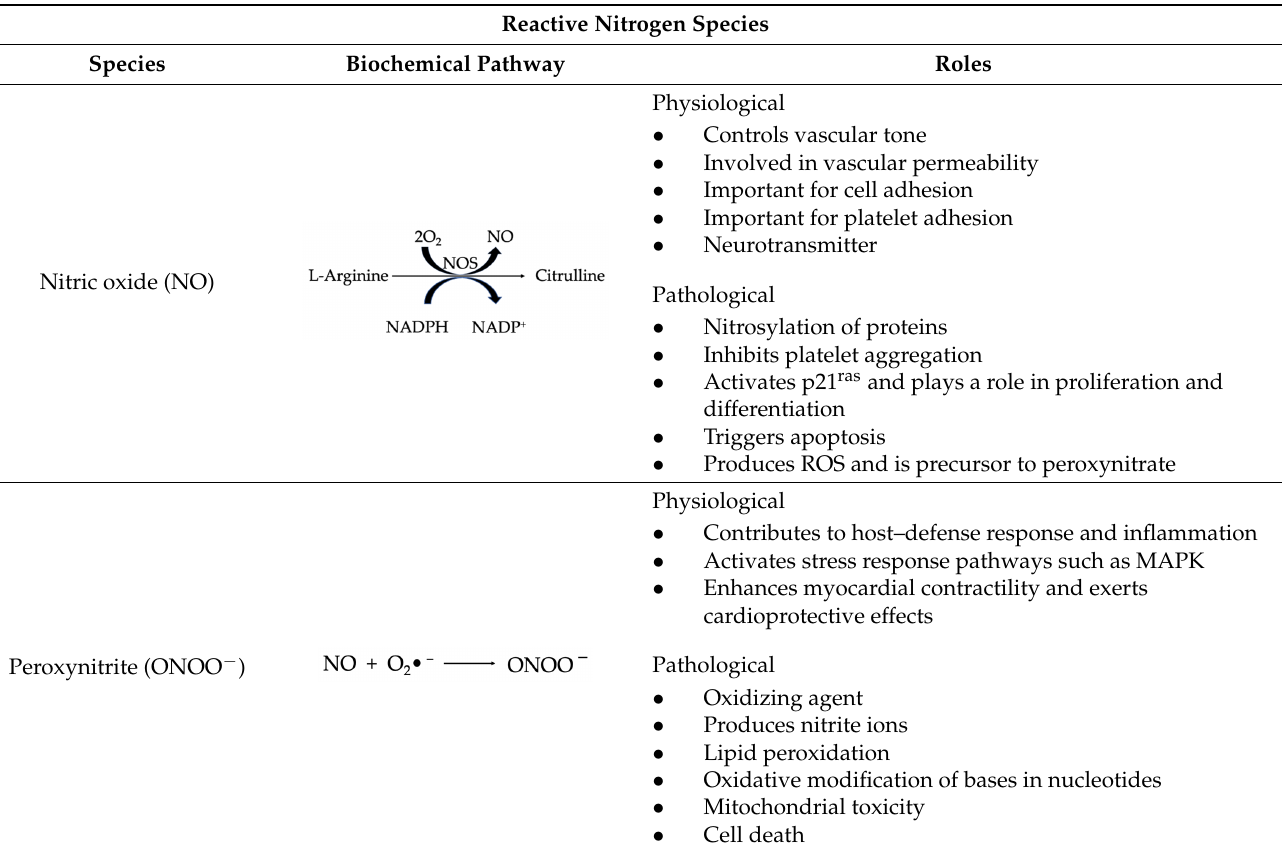
Table 2. Key reactive nitrogen species, the reactions that generate them and their physiological and pathological properties.